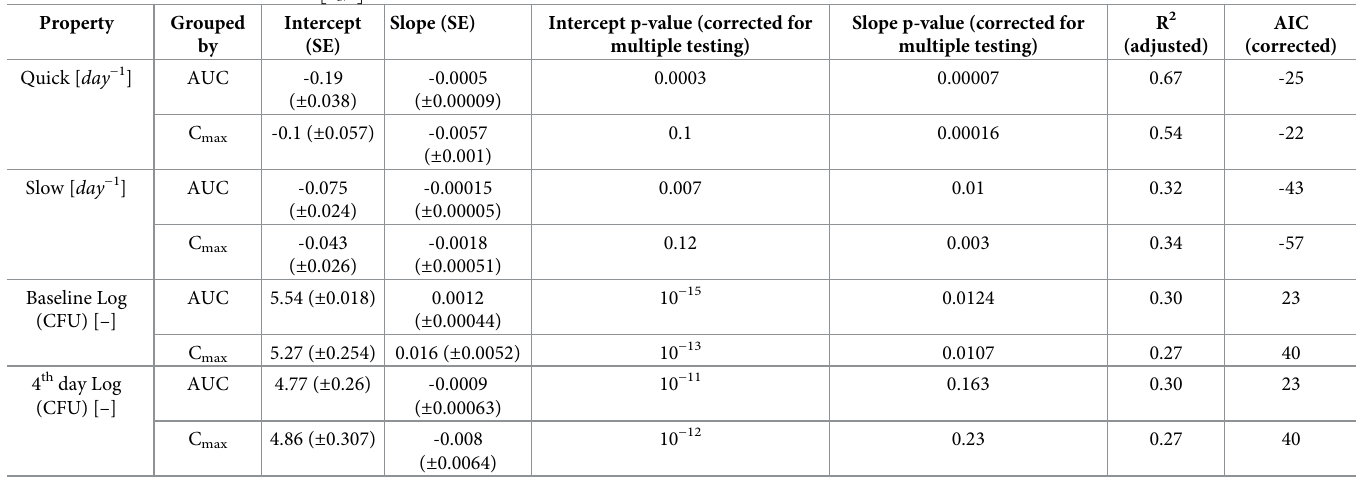
Table 2. Summary of the median fitted values to the dataset across all groupings, with day 4 as the day of transition from quick phase to slaw phase. All the P values reported are corrected for multiple testing with the Benjamini-Hochberg method. Here the overall decline rates (used in Eq (1)) within each phase can be calculated